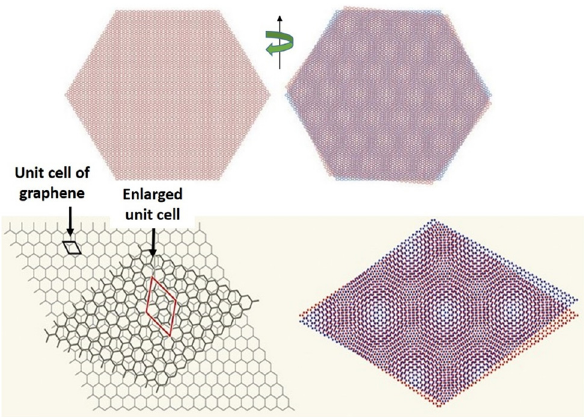
Figure 1: Two layers of graphene ( right ) that show a supercon - ducting properties when it twisted at angle 1.1°. Adapted from ref. [ 21,22 ]